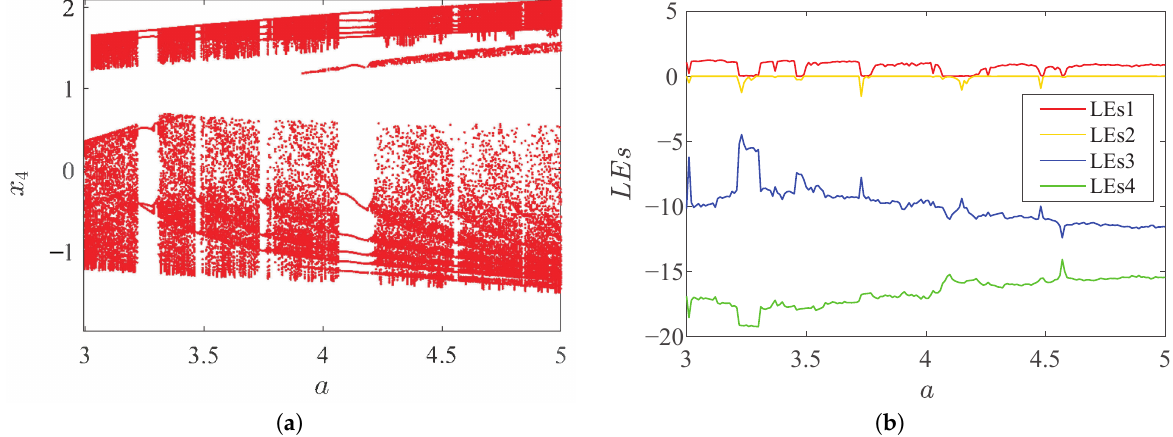
Figure 7. Dynamical behaviors with different parameter d of system (15). ( a ) Bifurcation diagram; ( b ) LEs.